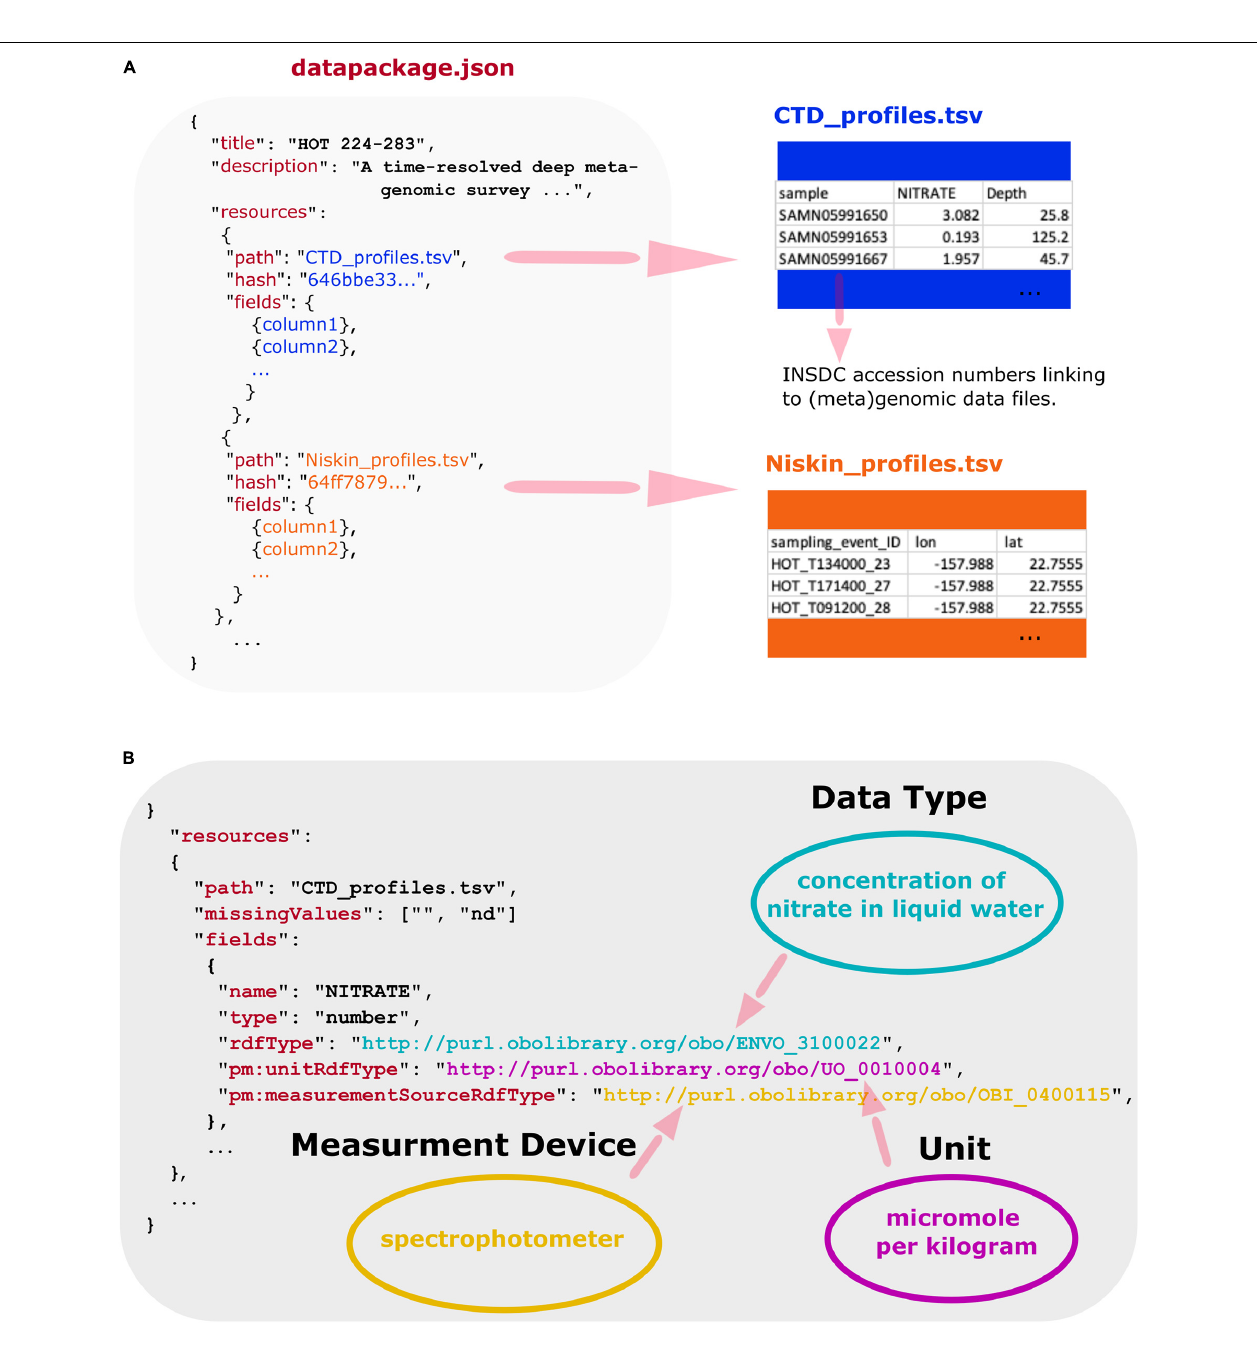
FIGURE 1 | (A) Overview of Planet Microbe Frictionless Data Packages that for any given project includes a “datapackage.json” file containing machine-readable descriptive information about the individual resource TSV files and their columns, as well as the original (or slightly modified) data files. Note that at least one data file per Data Package also includes data columns with International Nucleotide Sequence Database Collaboration (INSDC) accession numbers linking to (meta)genomic datasets. The machine readable JSON description enables data to be exposed to and processed by machine systems. Additionally, the JSON files contain information about the resource file path and md5 checksums (hashes) allowing for complete transferability of multi-component datasets between systems. (B) Simplified view of data annotations used to markup a dataset column in a Planet Microbe Frictionless Data Package for an individual data column from an example data set resource. Multiple reusability indicators are built into the system. This includes missing values checklists that describe datasets-specific strings specifying “NA” values or missing data. Additionally, the expected data type (e.g., “number”) is specified and can be used to validate the data to make sure it is